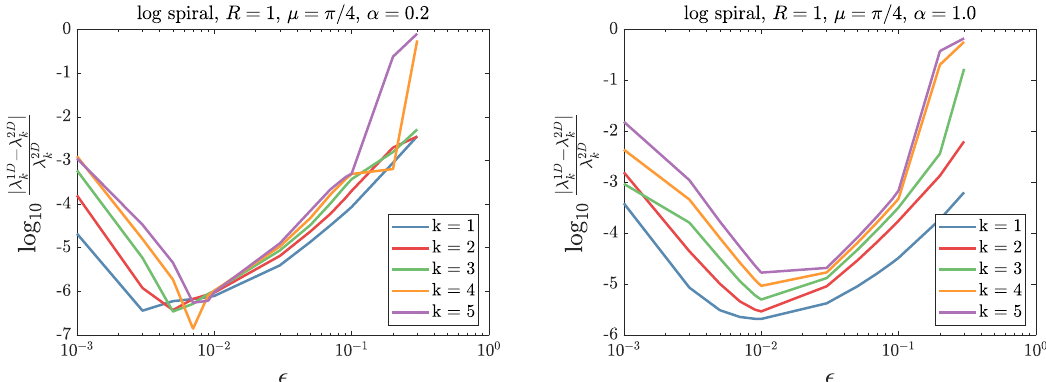
Figure A3. The relative difference between 1D and 2D calculations as a function of (cid:101) .